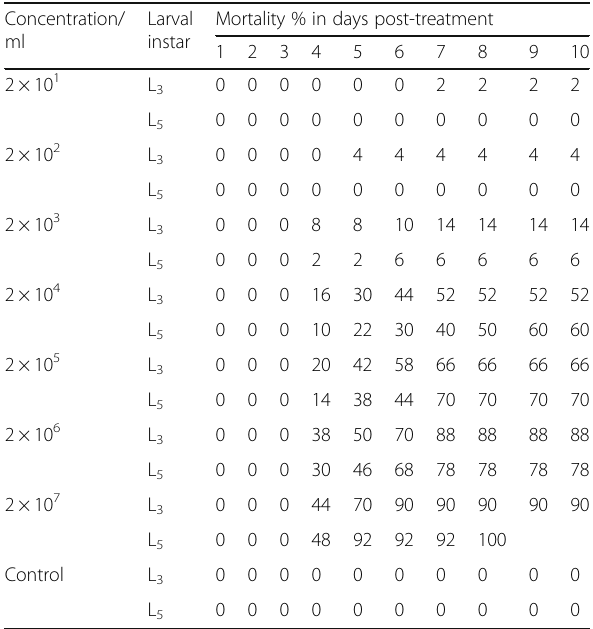
Table 1 Mortality % of Spodoptera littoralis (L 3 and L 5 ) treated with different concentrations of Metarhizium anisopliae conidiospores